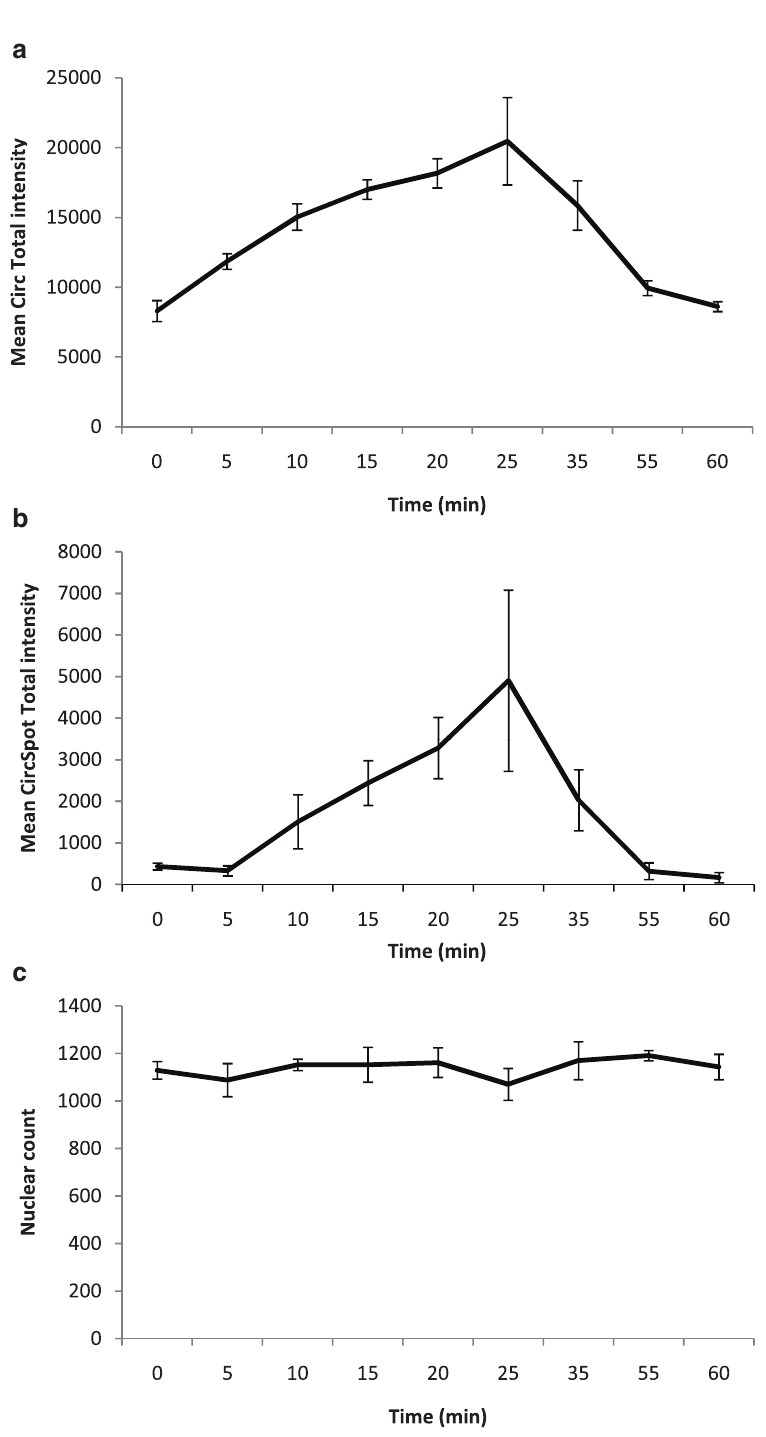
Figure 2. Parameter selection for nuclear PAR chains. ( a ) The cellular average (from 9 fields) of the total intensity of nuclear fluorescence of PAR after 250 µg/mL MMS as a function of time. ( b ) The cellular average (from 9 fields) of the total intensity of punctate nuclear fluorescence of PAR after 250 µg/mL MMS as a function of time. ( c ) Analysis of cell number using Hoechst-stained nuclei after dosing with MMS showing that there is no decrease in total cell number after 1 h